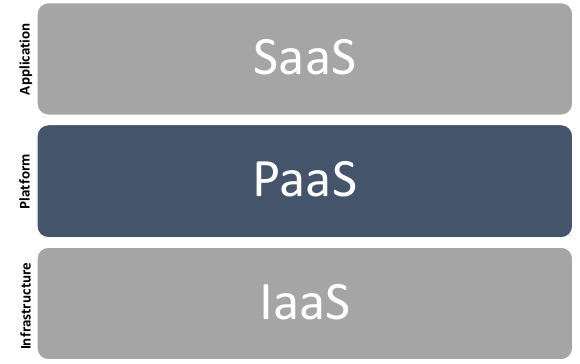
Fig. 1. The three common service models from cloud